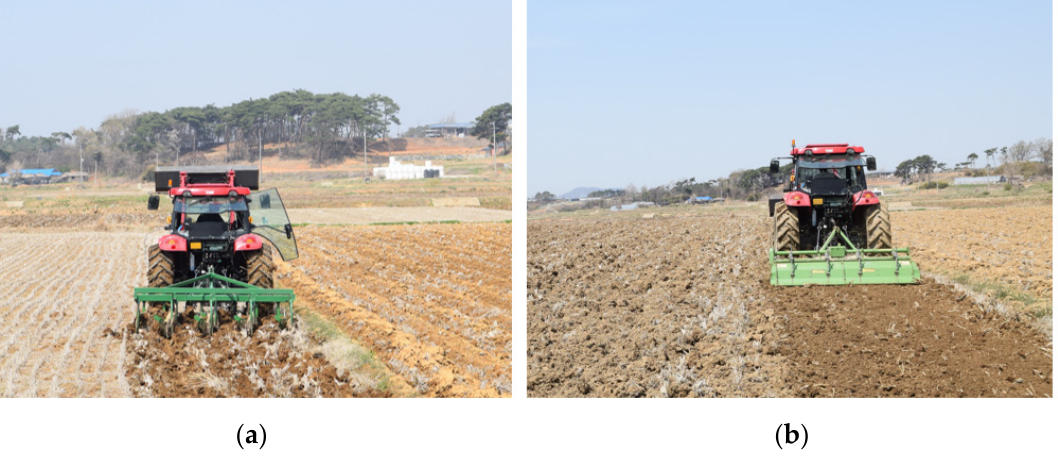
Figure 2. Photos of the 86 kW class agricultural tractor during the field test: ( a ) plow tillage; ( b ) rotary tillage.